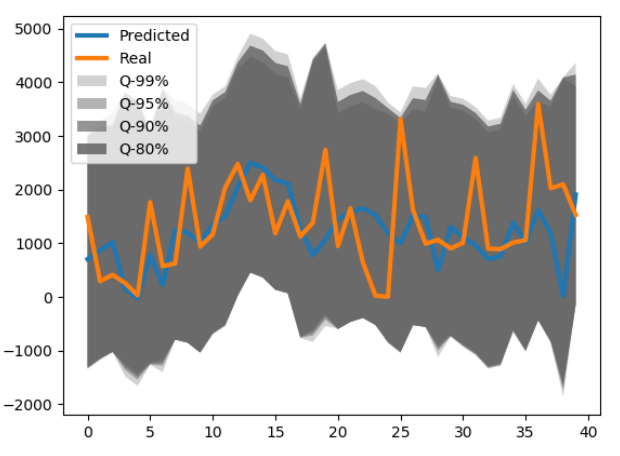
Figure 8. The result of interval prediction for warehousing out data.